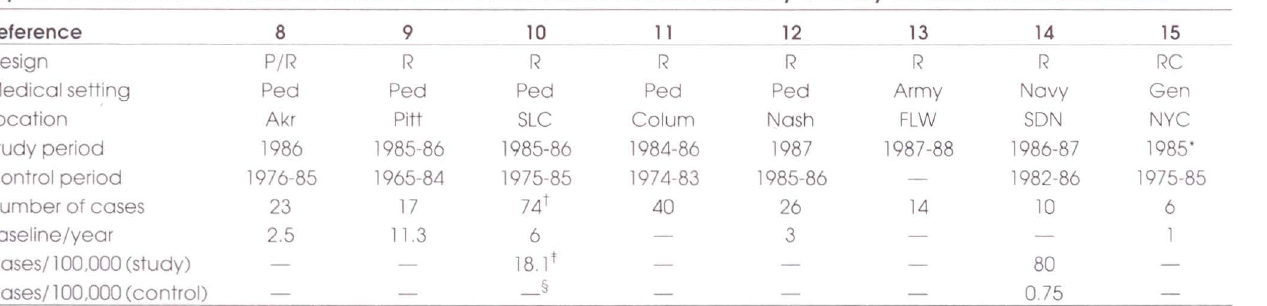
Reported outbreaks of acute rheumatic fever in the United States: Summary of study characteristics and